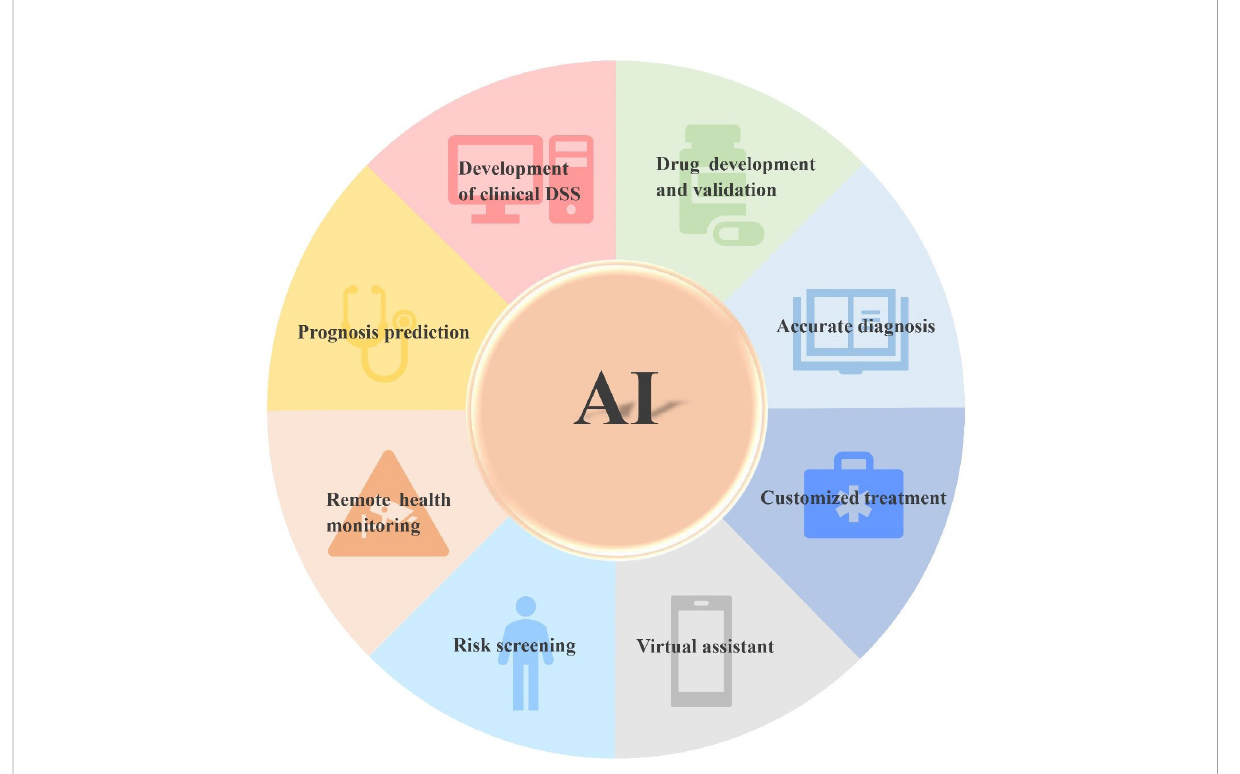
FIGURE 2 Application prospect of AI in